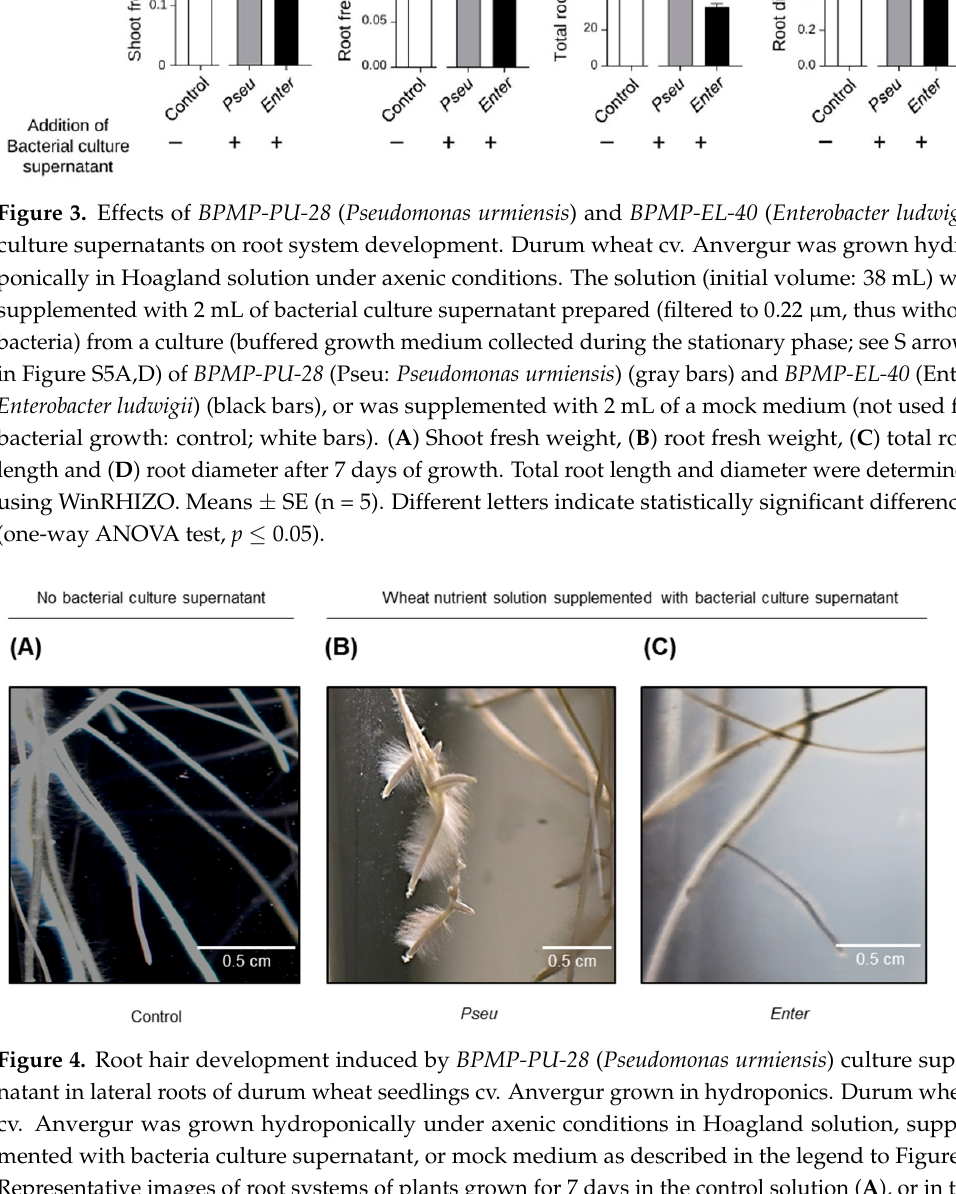
Figure 4. Root hair development induced by BPMP-PU-28 ( Pseudomonas urmiensis ) culture supernatant in lateral roots of durum wheat seedlings cv. Anvergur grown in hydroponics. Durum wheat cv. Anvergur was grown hydroponically under axenic conditions in Hoagland solution, supplemented with bacteria culture supernatant, or mock medium as described in the legend to Figure 3. Representative images of root systems of plants grown for 7 days in the control solution ( A ), or in the solution supplemented with 5% of BPMP-PU-28 (Pseu: Pseudomonas urmiensis ) culture supernatant ( B ) or supplemented with 5% of BPMP-EL-40 (Enter: Enterobacter ludwigii ) culture supernatant ( C ). Altogether, these results provide evidence that compounds impacting wheat root system development were present in the BPMP-PU-28 and BPMP-EL-40 growth supernatants. 2.5. Comparative Metabolomics Profiling of BPMP-PU-28 and BPMP-EL-40 Exudates